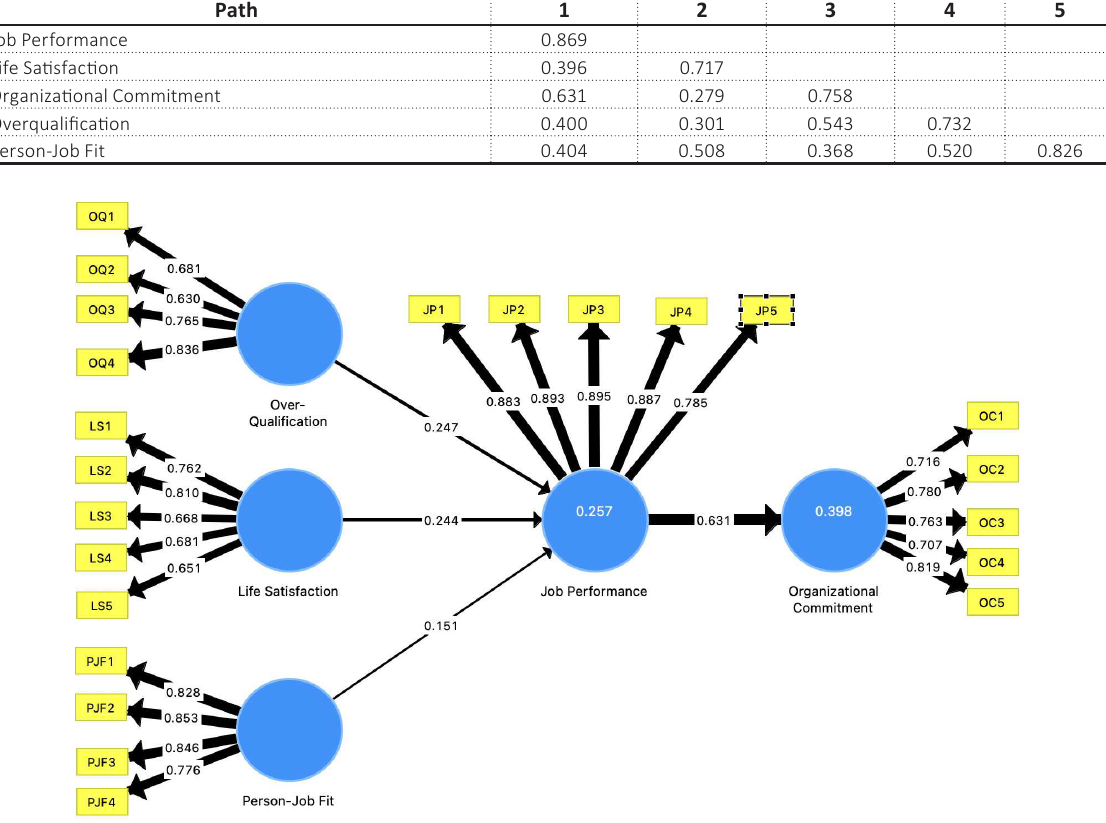
Figure 1. Structural